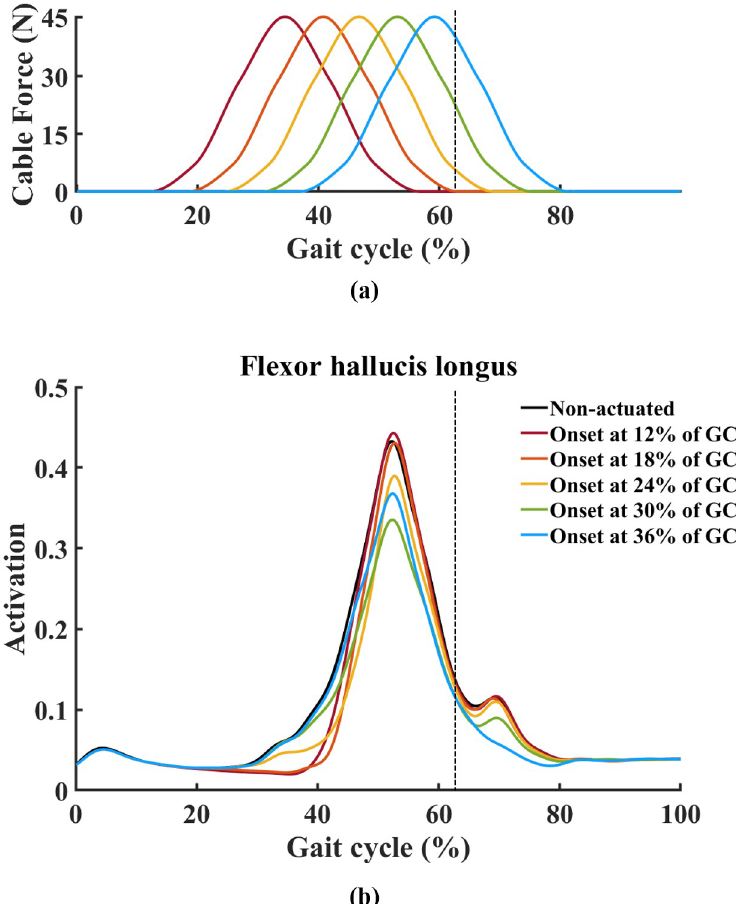
Fig 4. Five onset times and results for musculoskeletal simulation. (A) The five different onset times were at 12%, 18%, 24%, 30%, and 36% of the gait cycle. (B) The results of the simulations showed that the flexor hallucis longus activation was decreased the most compared to the flexor hallucis longus activation without the actuator when the onset timing was set to 30% of gait cycle. The dashed vertical line indicates toe-off event